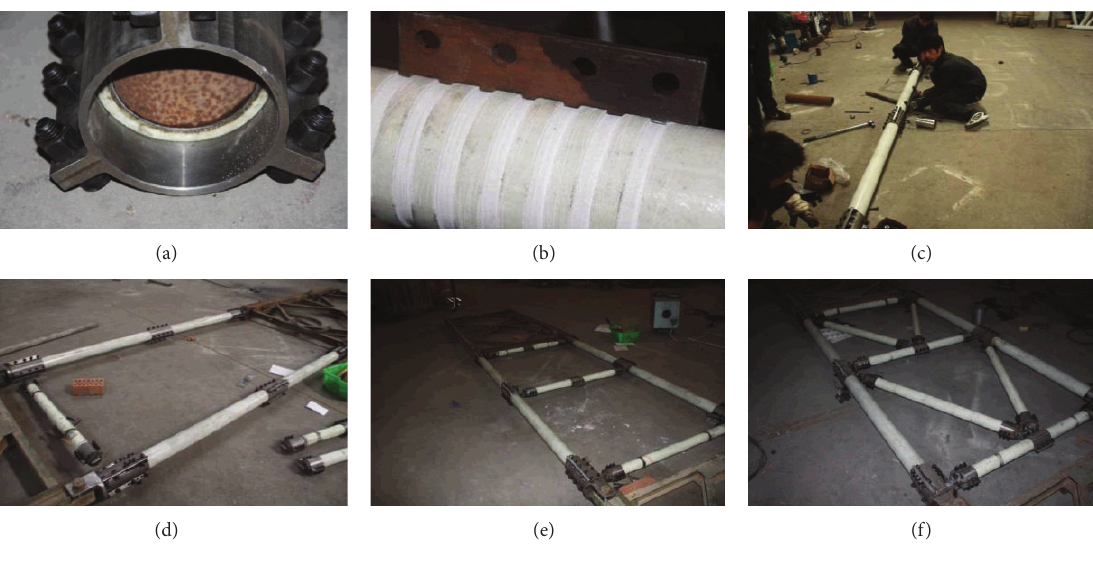
Figure 8: Assembly process of the